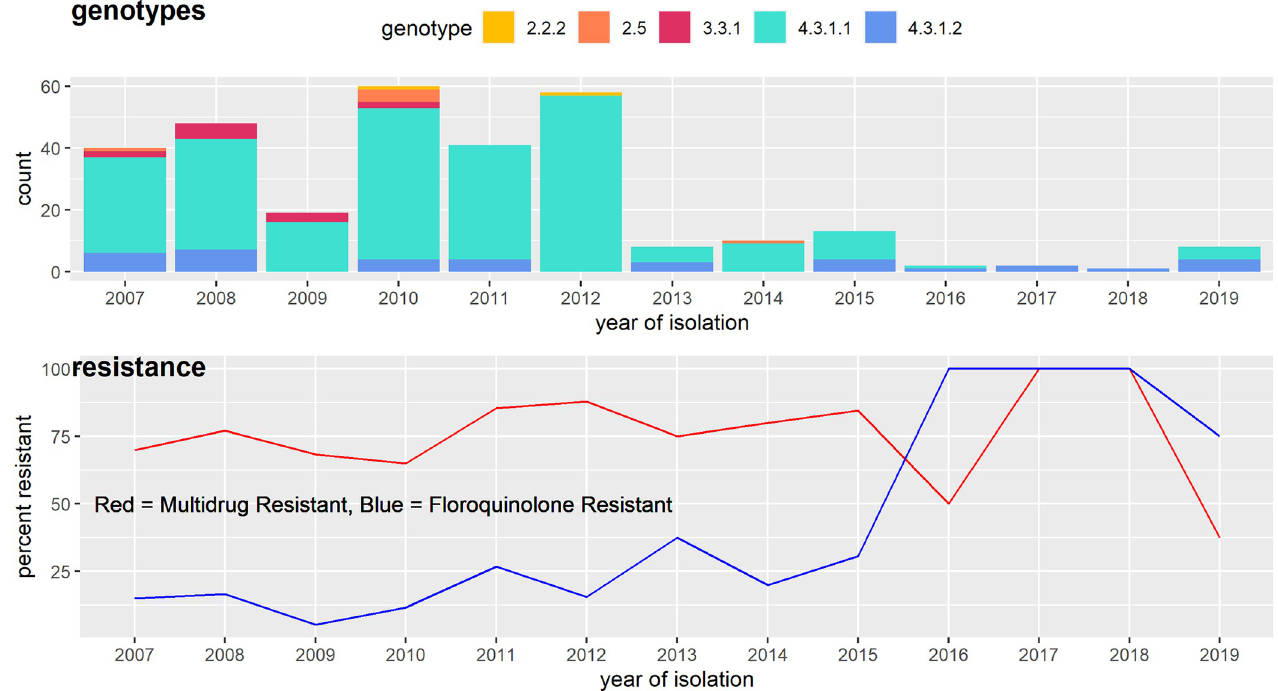
Fig 2. Temporal trends in genotype and antibiotic resistance by year of isolation. The top panel displays the genotype by year of isolation, where the x-axis is the year of isolation and the y-axis is count of isolates from that year belonging to each genotype. The bottom panel displays resistance information, where detection of determinants for a particular antimicrobial were employed as a proxy for resistance. The red line illustrates the percent of isolates over time with genes conferring resistance to ampicillin, chloramphenicol, and sulfa-methoxazole (defined as MDR). The blue line illustrates the percent of isolates with fluroquinolone resistance